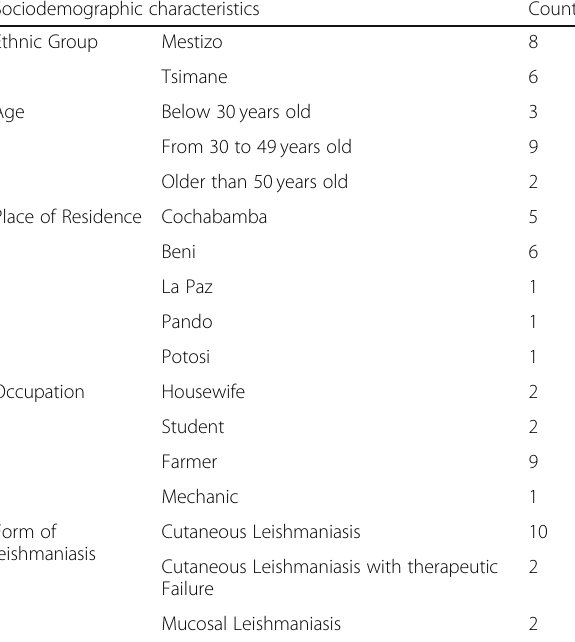
Table 1 Participants´ sociodemographic characteristics Sociodemographic